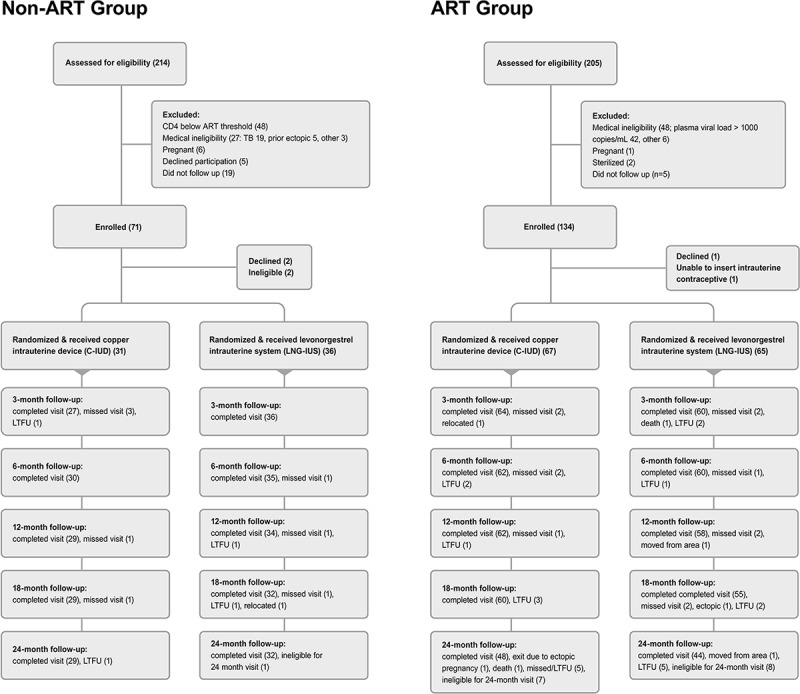
Trial recruitment and study activity flow chart.ART, antiretroviral therapy; C-IUD, copper intrauterine device; LNG-IUS, levonorgestrel intrauterine system; LTFU, loss to follow-up; TB, tuberculosis.